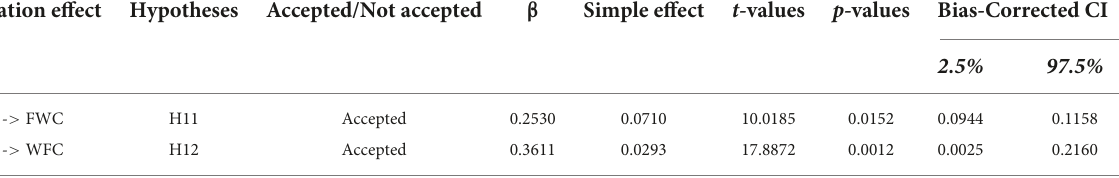
n = 362. TABLE 6 Moderation analysis.